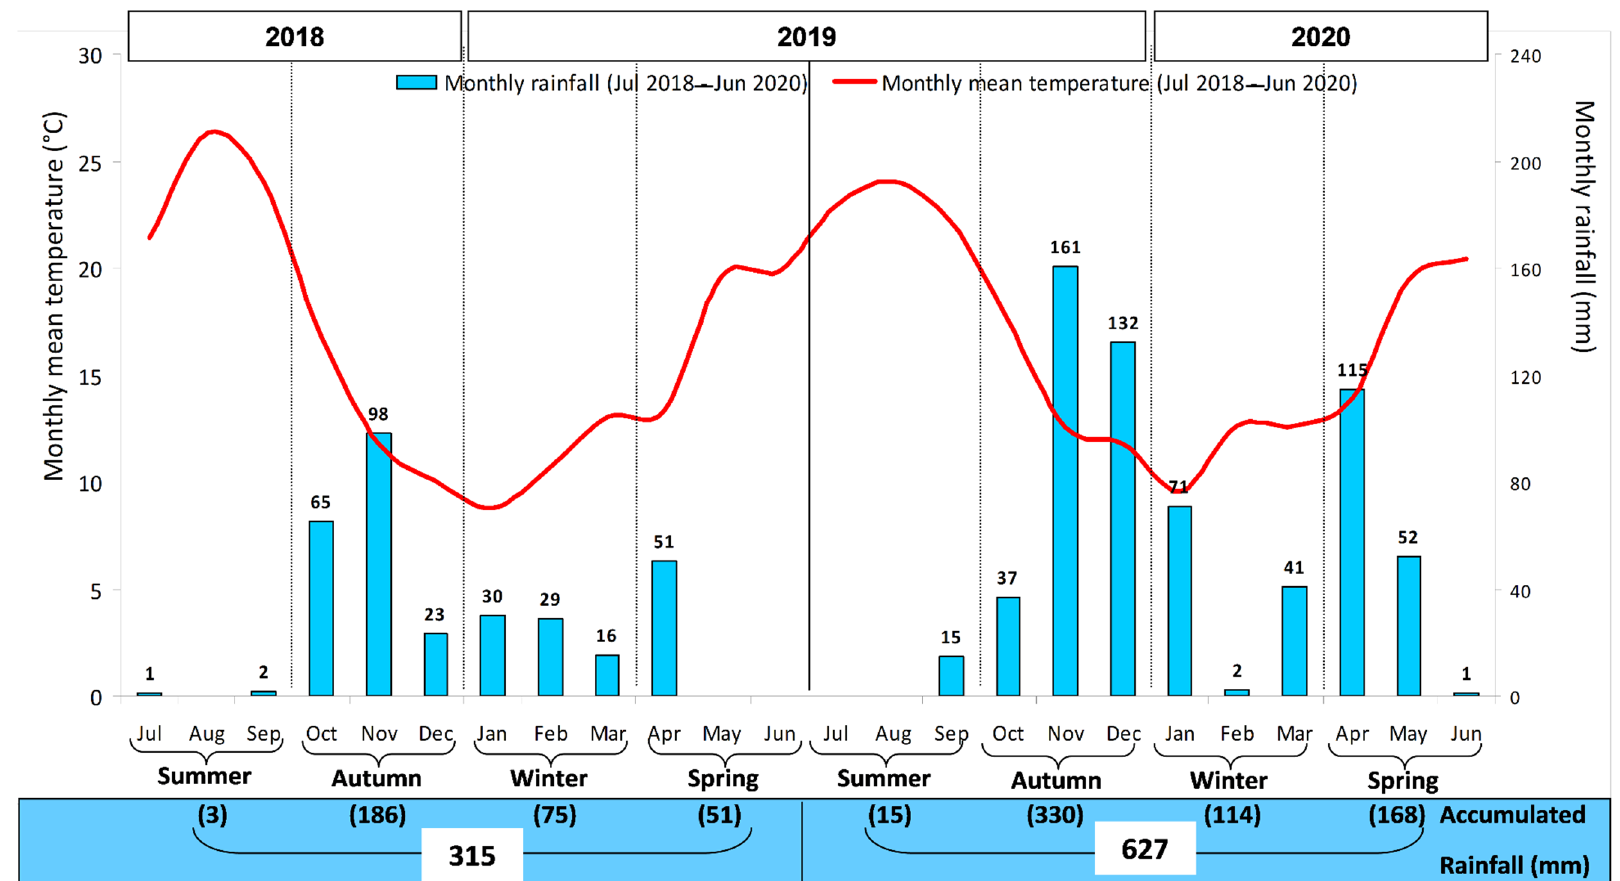
Figure 2. Thermo-pluviometric diagram of Meteorological Station of Mitra (Évora, Portugal) between July 2018 and June 2020. Is also indicates the accumulated rainfall by season and year.